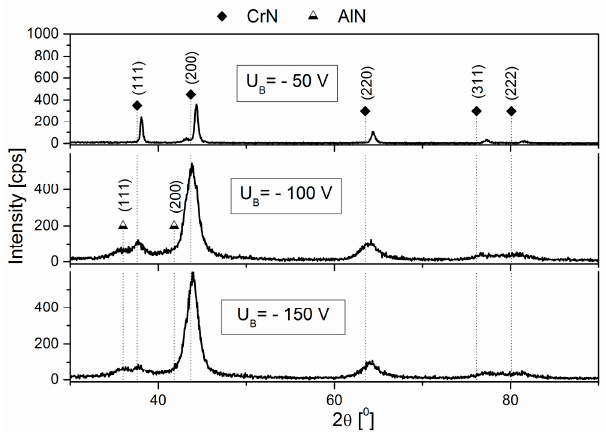
Figure 4. XRD diffraction patterns for AlCrN coatings deposited at temperature of 350 °C, nitrogen pressure of 3 Pa and various negative substrate bias voltages.